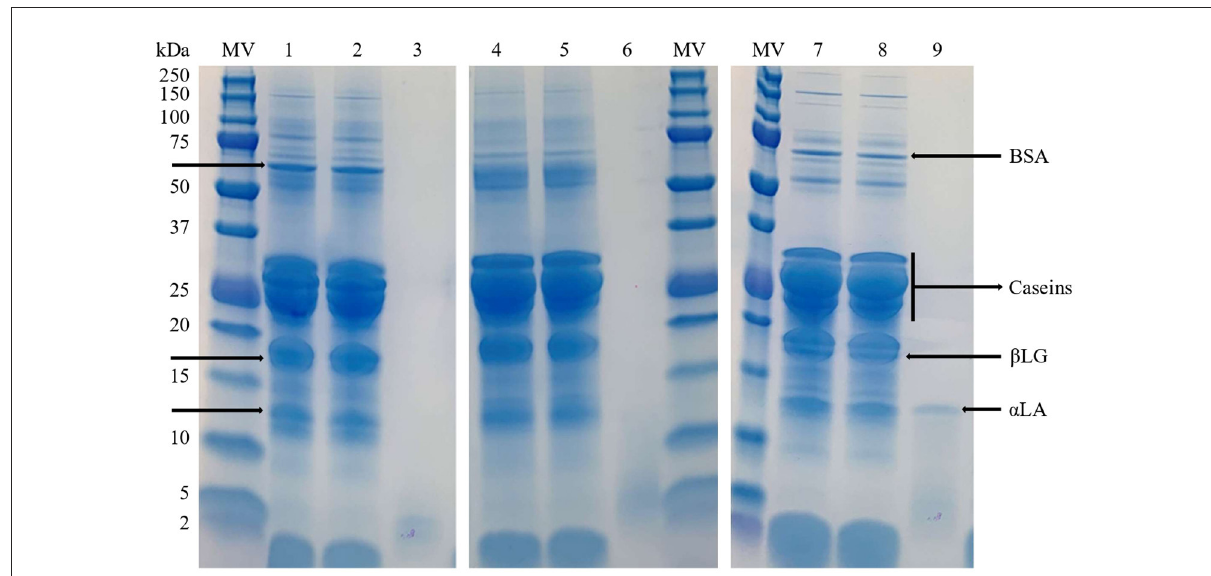
FIGURE1 SDS-PAGE analysis of cow milk (1), cow milk retentate (2), cow milk permeate (3), goat milk (4), goat milk retentate (5), goat milk permeate (6), sheep milk (7), sheep milk retentate (8) and sheep milk permeate (9). MW, Molecular weight standard; α LA, α -lactalbumin; β LG, β -lactoglobulin; BSA, bovine serum